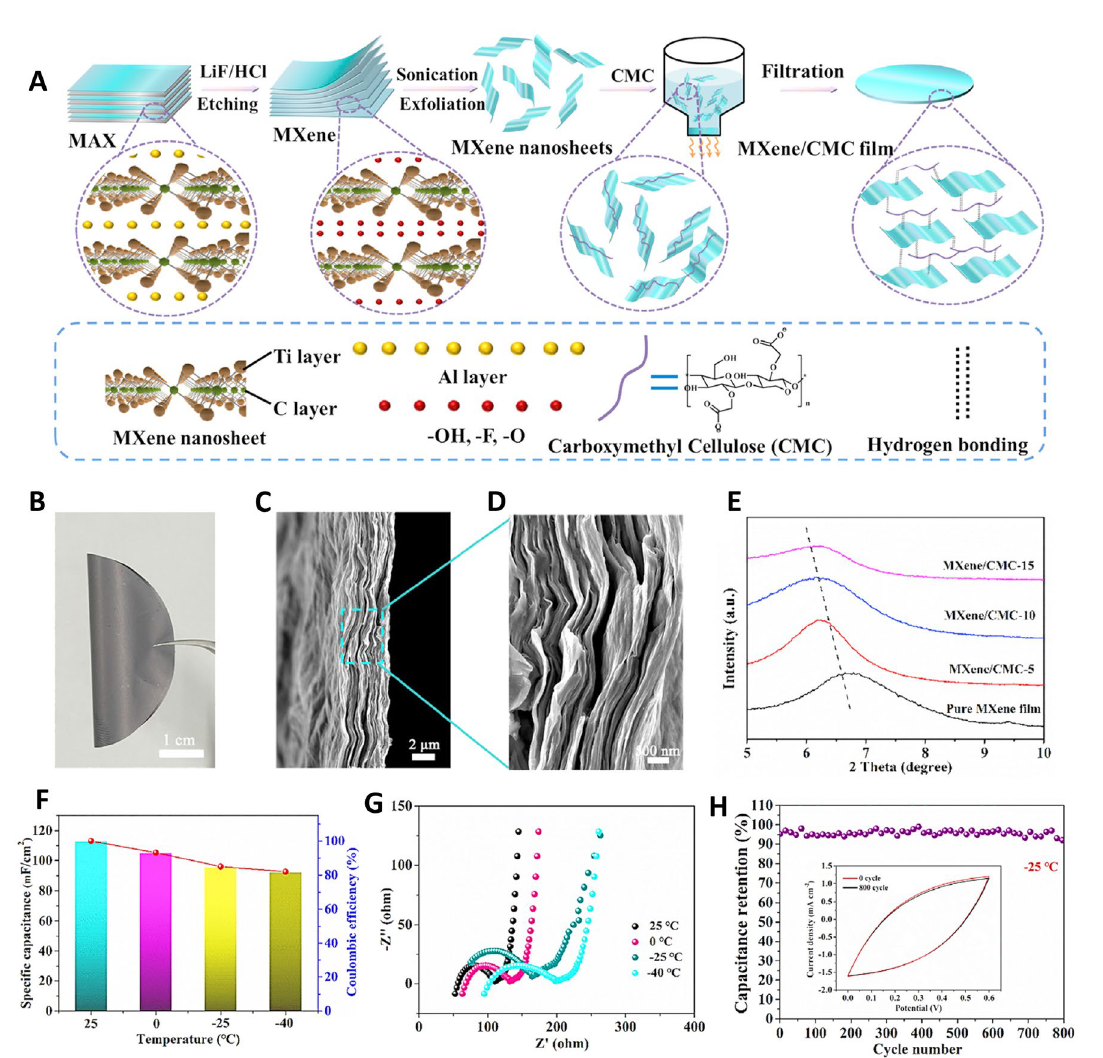
Fig. 3 A The preparative process of MXene/CMC film. B The image of the appearance of MXene/CMC-5 film. C , D Scanning electron microscopy (SEM) image of MXene/CMC-5 film. E X-ray diffraction (XRD) image of MXene/CMC films with different content of CMC. F Capacitance retaining of the supercapacitor under different temperatures. G Electrochemical impedance spectroscopy (EIS) spectra of the super- capacitor under different temperatures. H Cycle performance of the supercapacitor at 25 °C. Reproduced with permission from Ref. [61]. Copy- right 2022